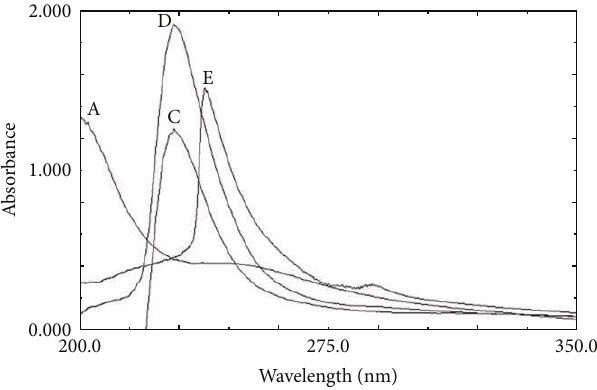
Figure 1: Spectra of the starting complex ( A ), glycyl-L-alanine ( L 1 -L 󸀠 H ) substituted complex ( C ), glycyl-L-aspergine ( L 2 -L 󸀠 H ) substituted complex ( D ), and glycyl-L-tyrosine ( L 3 -L 󸀠 H ) substituted complex ( E ); [complex A ] = 2.5 × 10 −4 moldm −3 , [dipeptide] = 7.5 × 10 −3 moldm −3 , pH = 4.3, cell used = 1cm quartz.